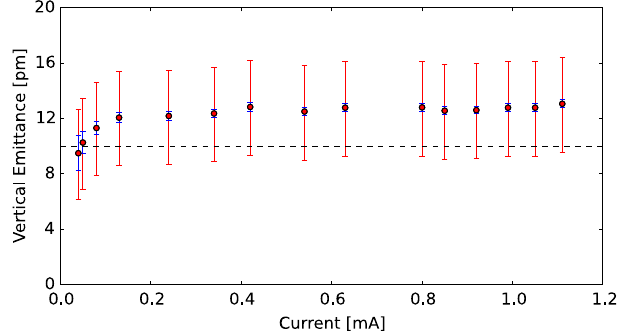
FIG. 5. Vertical emittance for a single bunch of positrons as a function of bunch current, from April 2013 CesrTA machine studies. Plotted error bars are systematic (red line) and statistical (blue line). The dashed horizontal line indicates the 10 pm zero-current vertical emittance target for